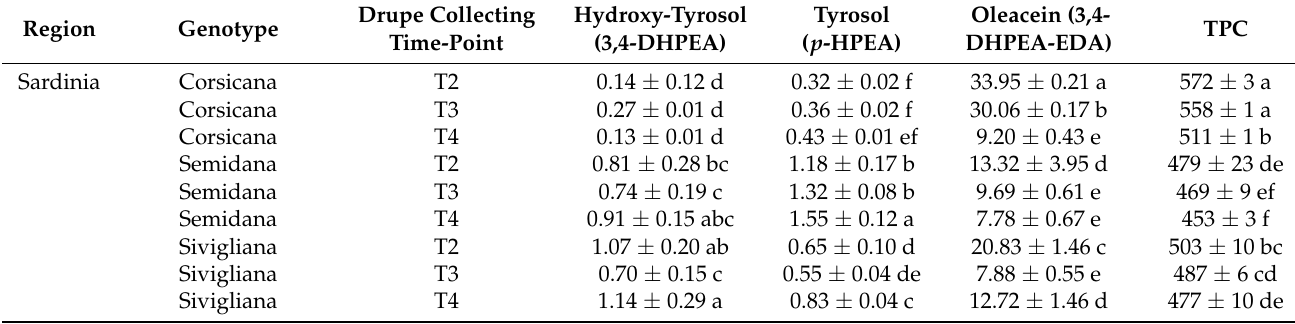
Table 3. Phenolic compounds and total phenolic content (TPC) detected in VOOs of all the analyzed cultivars from fruits at different ripening stages (T2 = turning drupes, T3 = almost dark drupes, T4 = fully dark drupes). Region